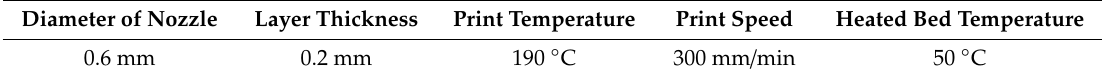
Table 1. Process